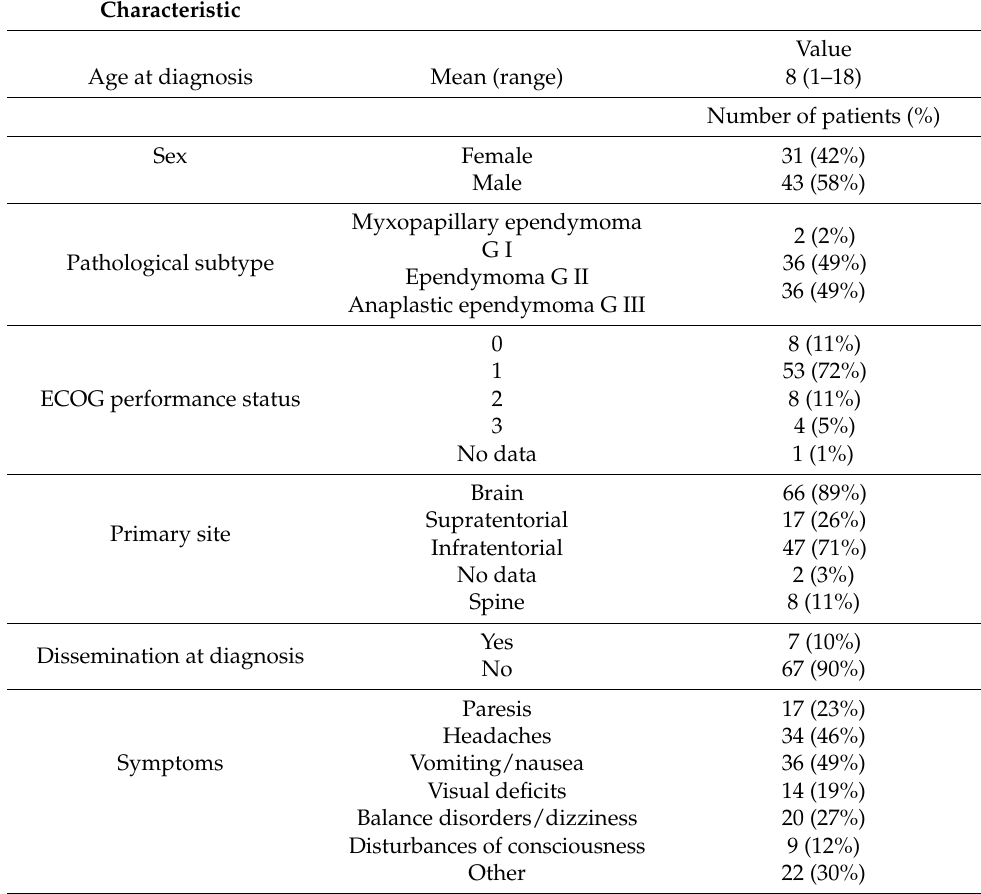
Table 1. The patients’ and treatment